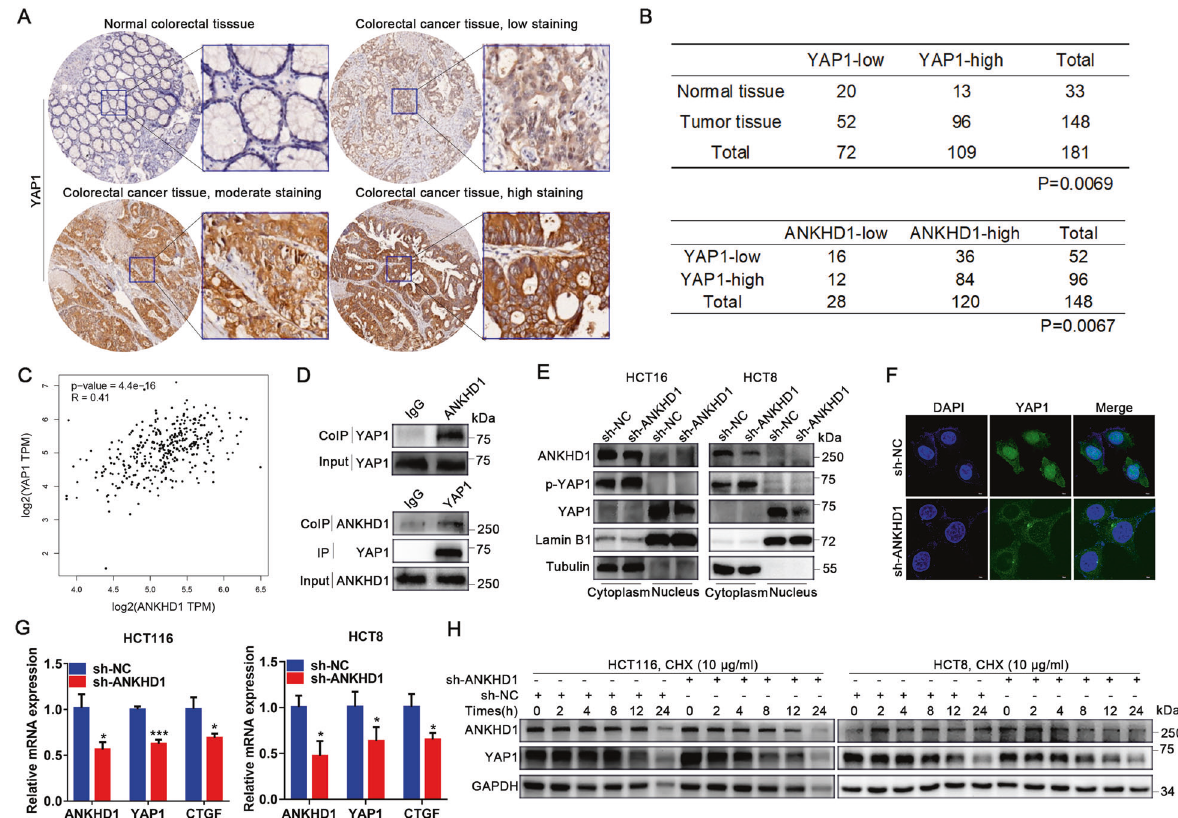
Fig. 4 The interaction between ANKHD1 and YAP1 stabilizes the transcriptional activity of YAP1. A The expression of YAP1 was tested by IHC in colorectal cancer tissue and normal tissue, and the staining of YAP1 in tumors was divided into three levels: low staining, moderate staining, and high staining. B The chi-square test showed an obvious difference in YAP1 expression between colorectal tumors and normal tissue (top, P < 0.005), and the chi-square test showed a high correlation of the expression of ANKHD1 and YAP1 in colorectal tumors (bottom, P < 0.05). C The correlation between the expression of ANKHD1 and YAP1 was analyzed in CRC using the GEPIA database ( P < 0.05). D Immunoprecipitation indicated that ANKHD1 could bind to YAP1 in HCT116 cells. E A nucleus-cytoplasm separation assay showed that ANKHD1 silencing decreased YAP1 expression in the nucleus and increased the phosphorylation of YAP1 in the cytoplasm. F The location of YAP1 was measured by immuno fl uorescence, indicating that ANKHD1 silencing inhibited the nuclear translocation of YAP1. G qRT-PCR was performed to detect the mRNA expression of ANKHD1, YAP1, and CTGF, and the data are presented as the mean ± SD (* P < 0.05, *** P < 0.001). H Western blot analysis showed that ANKHD1 silencing increased the degradation of ANKHD1 and YAP1 after CHX treatment (10 μ the cytoplasm, which ensured the nuclear accumulation and transcriptional coactivation of YAP1. The feedback loop of ANKHD1/MALAT1/YAP1 is responsible for YAP1 activity Quantitative proteomics revealed that ANKHD1 was an interacting protein of MALAT1, but the interaction between ANKHD1 and MALAT1 was not veri fi ed, especially their co-effect on radio- sensitivity [22]. By applying bioinformatics analysis based on GEPIA database, MALAT1 expression was found to be closely related to ANKHD1 in CRC (Fig. 5A), which was veri fi ed by qRT-PCR (Fig. 5B, C). To further verify the interaction, the cellular localization of MALAT1 and ANKHD1 was examined by FISH combined with IF staining. MALAT1 and ANKHD1 were colocalized in the cytoplasm of CRC cells (Fig. 5D). Furthermore, the RIP assay showed an obvious enrichment of MALAT1 in anti-ANKHD1 with greater than 40-fold enrichment compared with anti-IgG (Fig. 5E). Reciprocally, RNA pull-down and Western blot analysis showed that ANKHD1 could bind with MALAT1 (Fig. 5F). These results indicated that MALAT1 physically associates with ANKHD1. In addition, the positive correlation between MALAT1 and YAP1 was predicted in CRC based on GEPIA database (Fig. 5G), which was con fi rmed by qRT-PCR that the abundance of YAP1 mRNA was signi fi cantly decreased in MALAT1-silenced CRC cells (Fig. 5C).